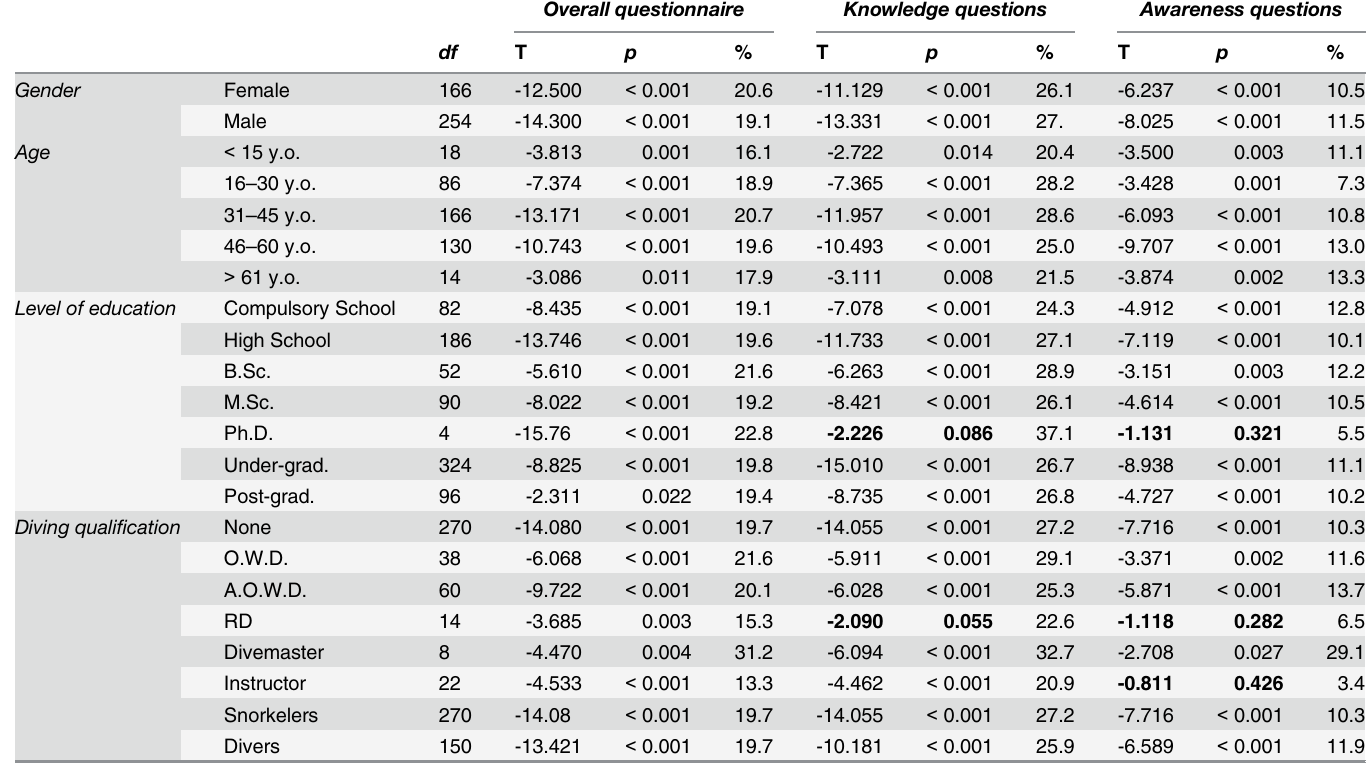
Table 2. Results of T-student test and the percent increase between the score of the post-questionnaire and the score of the pre-questionnaire for the overall questionnaire, the reef biology and the human impact